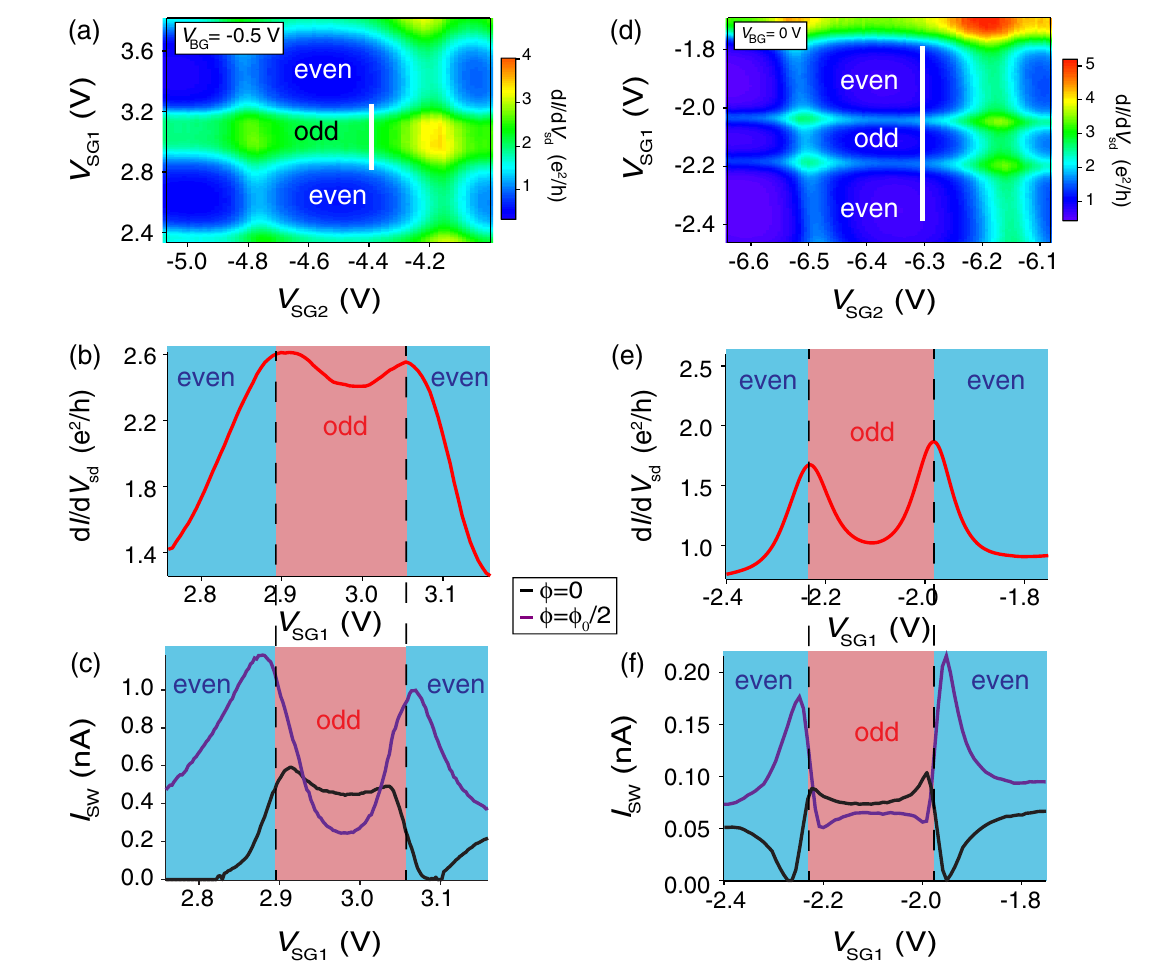
FIG. 4. 0 - (cid:1) transition in Kondo- and Coulomb-blockaded odd-charge states. Panels (a), (b), and (c) show, respectively, the stability diagram, the normal-state conductance along the white line in (a), and the supercurrent, in the case of a well-developed Kondo effect. Panels (d), (e), and (f) show, respectively, the stability diagram, the normal-state conductance along the white line in (d), and the supercurrent, in the case when Coulomb blockade is not overcome by the Kondo effect. Supercurrent sign reversal, observed by the crossing of the two curves at (cid:3) ¼ 0 and (cid:3) ¼ (cid:3) 0 = 2 , respectively, penetrates in (c) deep within the odd-charge Coulomb diamond thanks to Kondo screening, in contrast to (f), where the 0 - (cid:1) crossing occurs precisely when the valence changes from even to odd and from odd to